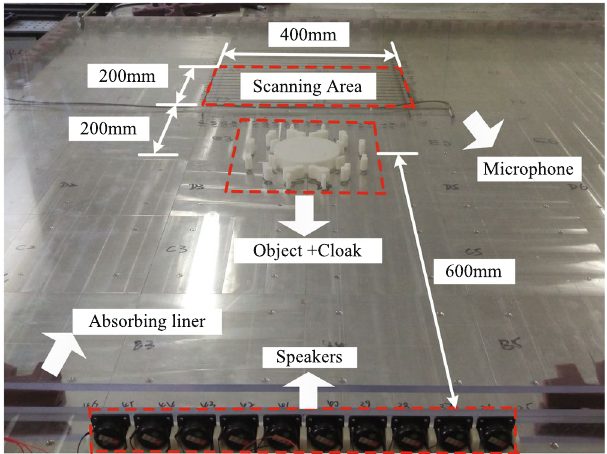
Figure 7. Photograph of the experimental setup with some dimension of